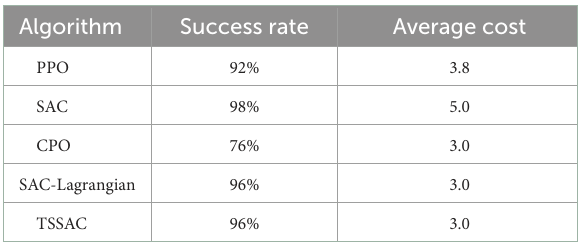
TABLE 4 Comparison of test